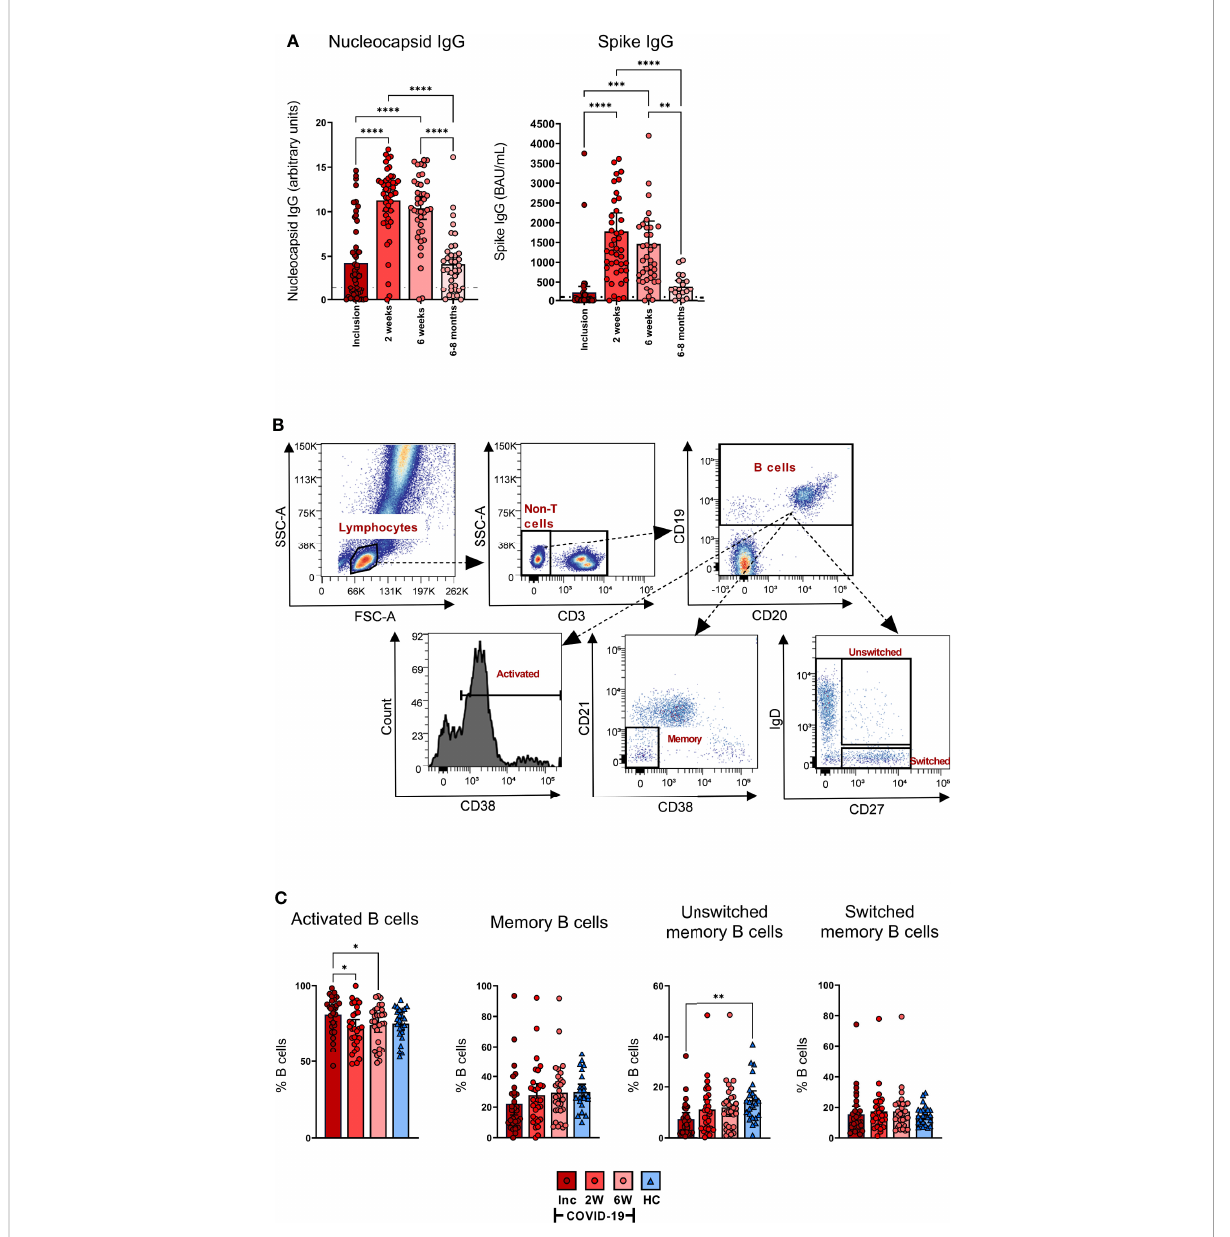
FIGURE 7 All COVID-19 patients develop SARS-CoV2-speci fi c antibody responses and have activated B cells early in the disease. Sera were collected from COVID-19 patients that required hospitalization (N=46) and healthy donors (N=31). (A) The levels of nucleocapsid antibodies (Units, 0.8-1.4 borderline positive and > 1.4 for positive result) (left) and spike antibodies (BAU/ml, ≥ 30 for positive result) (right) were measured in sera from inclusion up to 6-8 months. (B) Representative gating to determine B cell proportions and activation states using CD3, CD19, CD20, CD21, CD38, IgD, and CD27. (C) The B cell populations measured by fl ow cytometry as percentage out of the CD19 + B cells; CD19 + CD38 + B cells (activated B cells), CD19 + CD27 + B cells (memory B cells), CD19 + CD27 + IgD + B cells (unswitched B cells), and CD19 + CD27 + IgD - B cells (Switched B cells). Data is represented as mean with 95% Cl, with signi fi cance of *p ≤ 0.05, **p ≤ 0.01, ***p ≤ 0.001, ****p ≤ 0.0001, determined using Brown-Forsythe and Welch ANOVA tests. Inc = Inclusion in study at the hospital, 2W = 2 weeks, 6W = 6 weeks, HC = healthy